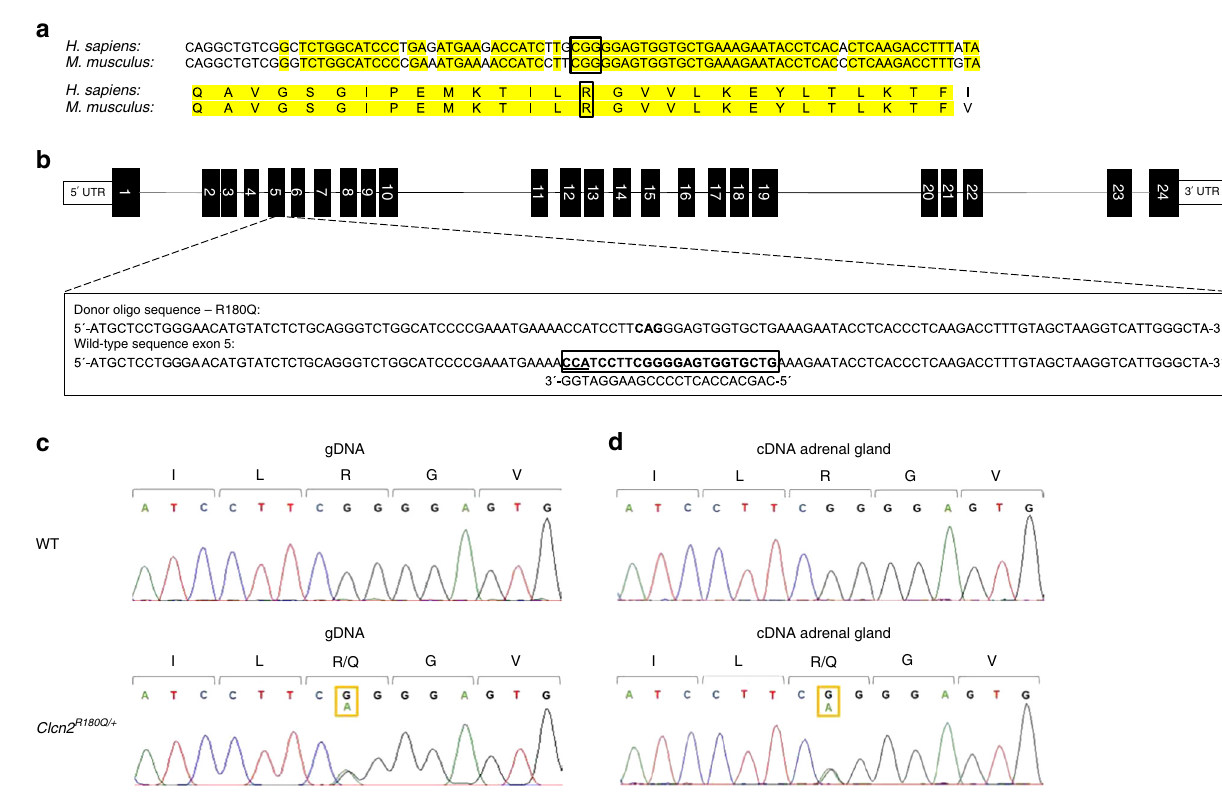
Fig. 1 Generation of a heterozygous Clcn2 R180Q/ + mouse model. a Alignment of human and mouse protein and genomic sequence surrounding human Arg172 that is commonly mutated in FH-II. b Representation of the mouse Clcn2 locus with the targeted codon on exon 5. Sequence of gRNA to target the Cas9 nuclease to exon 5 of the mouse Clcn2 gene is shown below the wildtype sequence. The PAM is underlined. The mutation is introduced by homology- directed repair using a donor oligonucleotide (oligo), with the mutant codon shown in bold letters. c Sanger sequences of a Clcn2 R180Q/ + mouse and a WT control. d Sanger sequences of adrenal cDNA from a Clcn2 R180Q/ + mouse and a WT control. gDNA, genomic